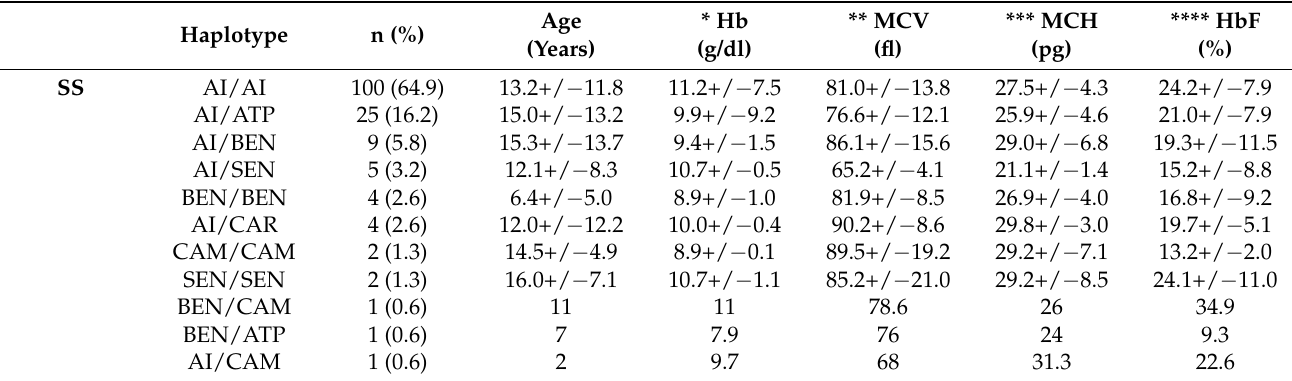
Table 5. Haplotypes among HbSS